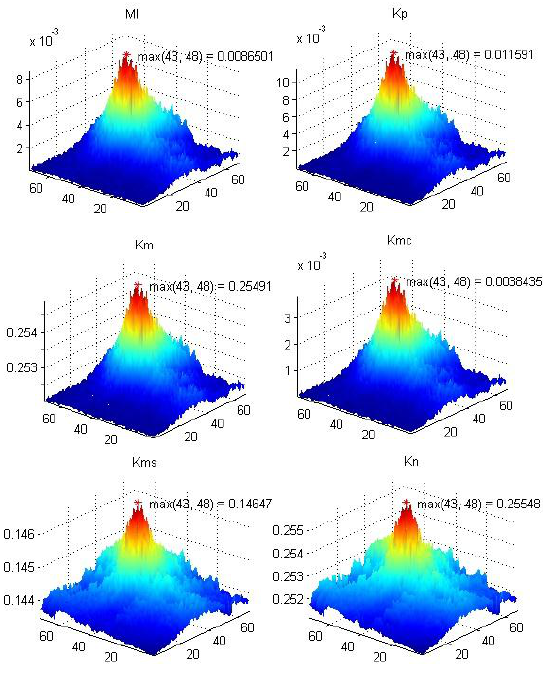
Figure 4. Correlation fields for TV-IR matching (Example